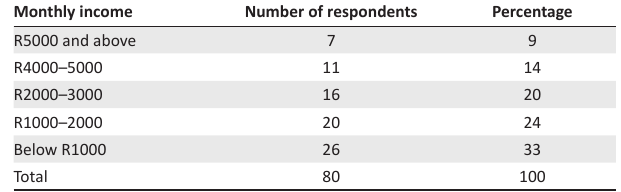
TABLE 3: Monthly income of the respondents.